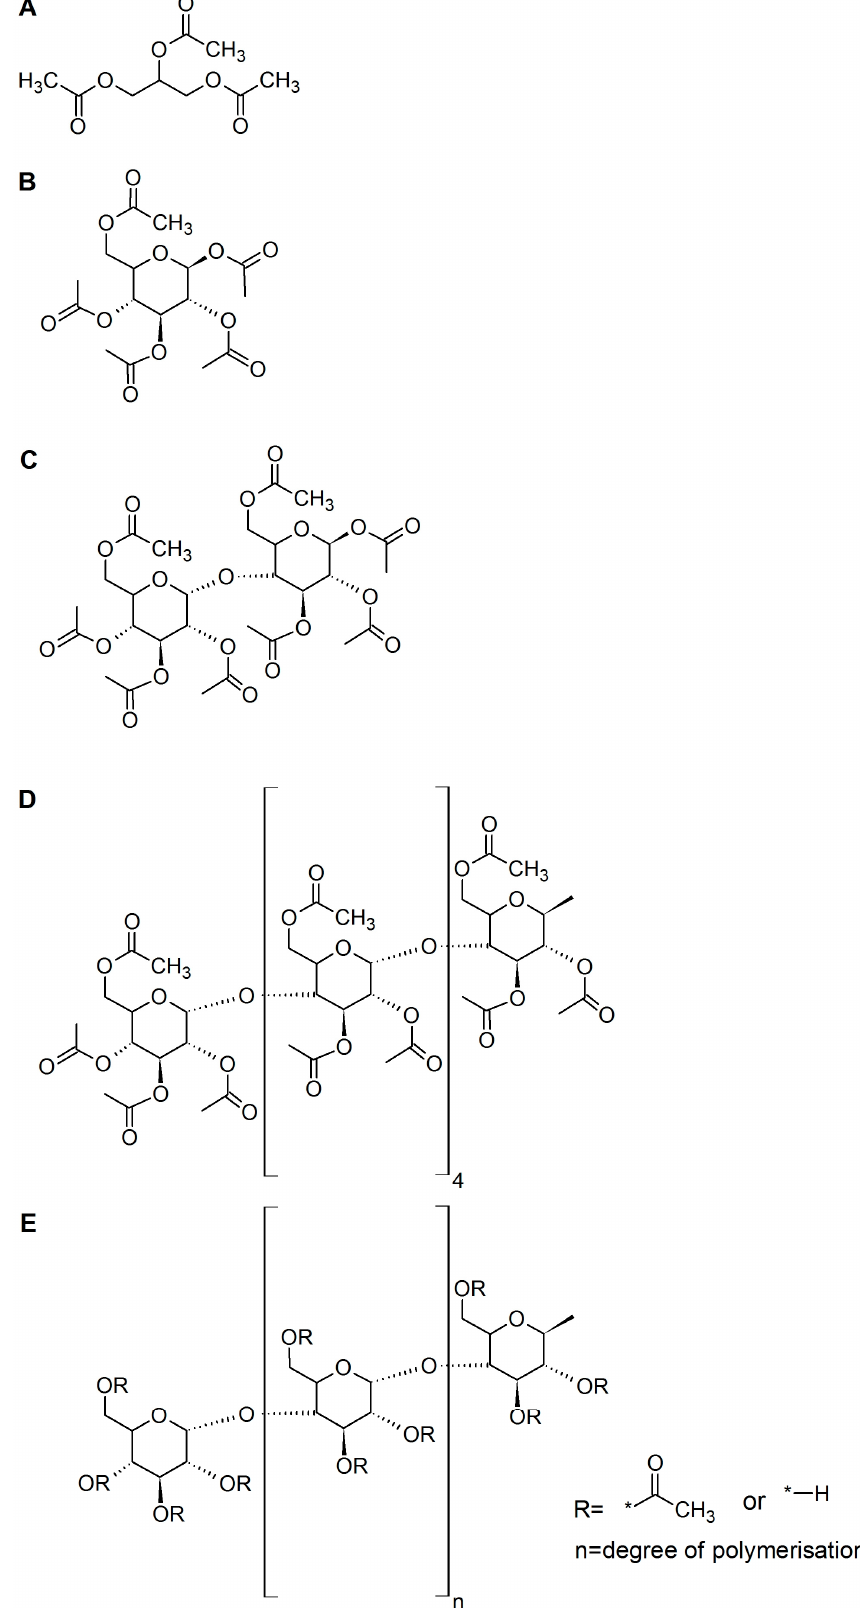
Figure 1. Substrates for enzymatic CA degradation. Triacetin ( A ); glucose pentaacetate ( B ); cellobiose octaacetate ( C ); hellohexose eicosacetate ( D ); and CA ( E ). For CA: R refers for the degree of substitution and n + 2 is the degree of polymerization.